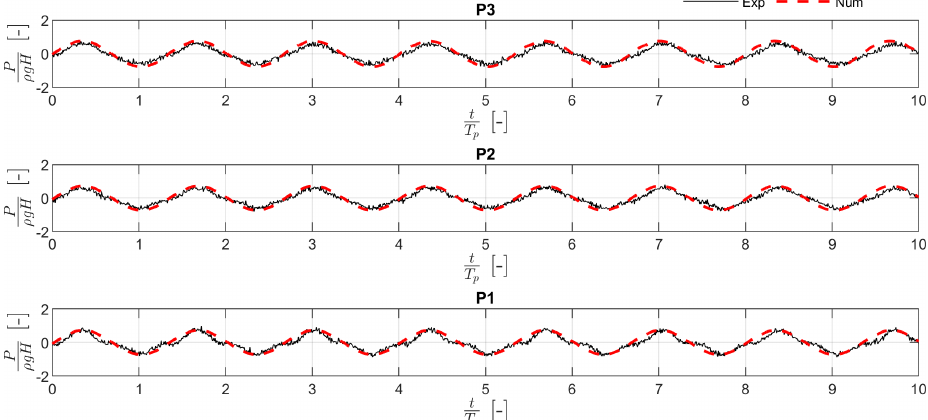
Figure 6. Comparison between the pressure measured in the experimental campaign by the three transducers located on the rear wall and that estimated by the numerical model. The data refer to a wave with kd =